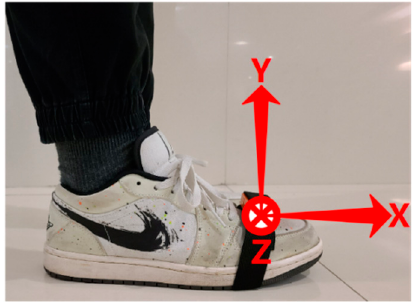
Figure 1. The IMU position and the direction of each axis.